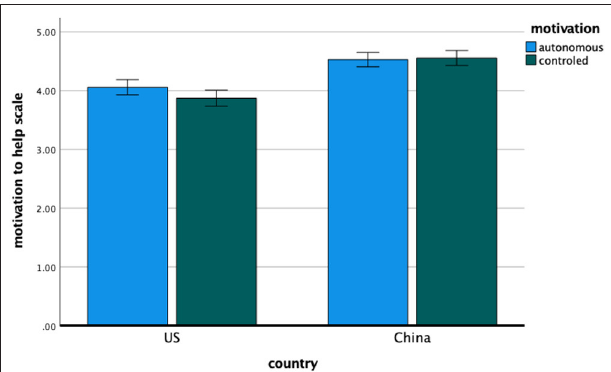
FIGURE 3 | Study 1—the autonomous and controlled motivation from Motivation to Help Scale for American and Chinese participants. Error bars denote 95% confidence intervals of the